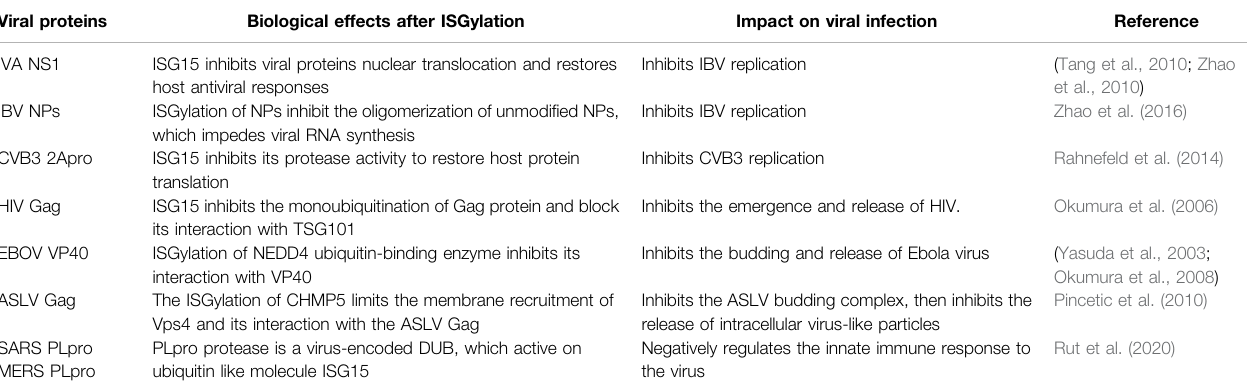
TABLE1 | Interaction between ISG15 and viral proteins. Viral proteins Biological effects after